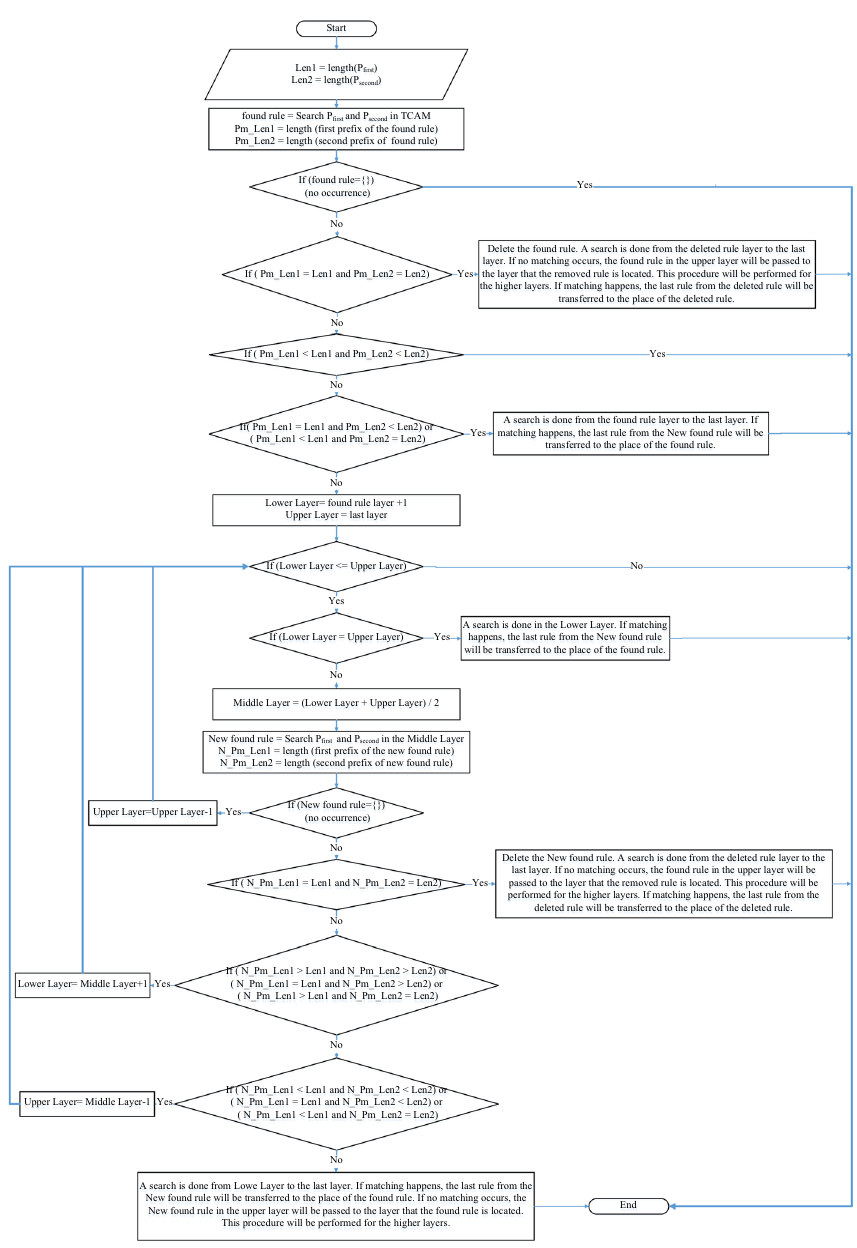
Fig. 9 The flowchart of deleting a rule in the second